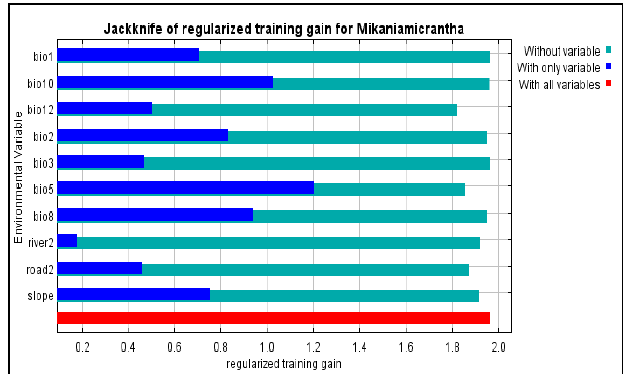
Figure 8: Jackknife of Regularized Training Gain for Mikania